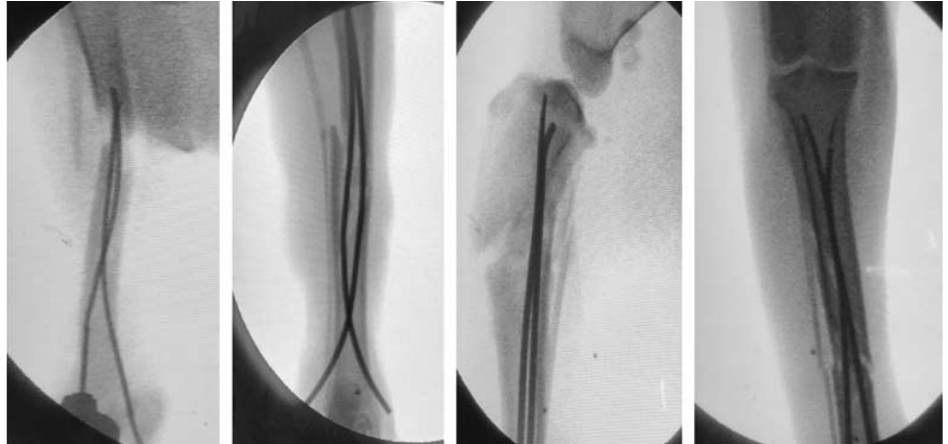
Fig. 3. Intraoperative C-Arm radiographs of different dogs during repair of fracture of tibia by using ESIN by using TENs